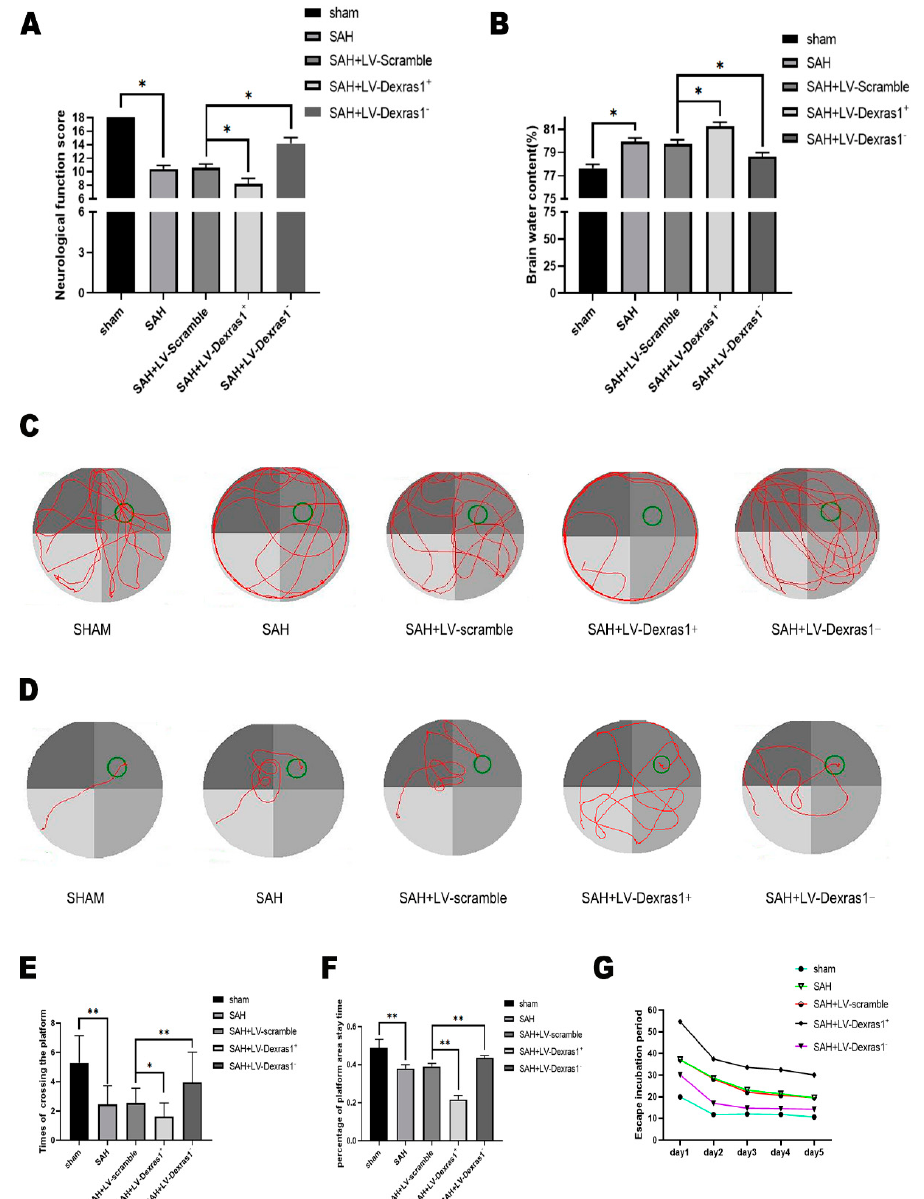
Figure 5. ( A ) Analysis of neurological deficits at 24 h in each group; * p < 0.05 sham vs. SAH rats, * p < 0.05, SAH+LV-Dexras1 + vs. SAH+LV-Scramble rats, * p < 0.05 SAH+LV-Dexras1 − vs. SAH+LV-Scramble rats; ( B ) evaluation of water content in brain tissue in each group after SAH, * p < 0.05 sham vs. SAH rats, * p < 0.05 SAH+LV-Dexras1 + vs. SAH+LV-Scramble rats, * p < 0.05 SAH+LV-Dexras1 − vs. SAH+LV-Scramble rats; ( C ) day 6 tracks of all rats; recording was done for 90 s after training platform removal; ( D ) representative images of the shortest path of each group to the platform during the acquisition trials in the MWM examination; ( E ) the number of times each group crossed the platform; recording was done for 90 s after training platform removal, (* p < 0.05, ** p < 0.01); ( F ) analysis of the percentage of time rats remained in the target quadrant during the spatial exploratory test, (** p < 0.01); ( G ) 7 days post-SAH, rats were allowed to search for the hidden platform for 90 s; each acquisition trial was part of 4 trials, one per day, for 5 days. Data represent mean ± SD, n = 5, * p < 0.05 sham vs. SAH rats, * p < 0.05 SAH+LV-Dexras1 + vs. SAH+LV-Scramble rats, * p < 0.05 SAH+LV-Dexras1 − vs. SAH+LV-Scramble